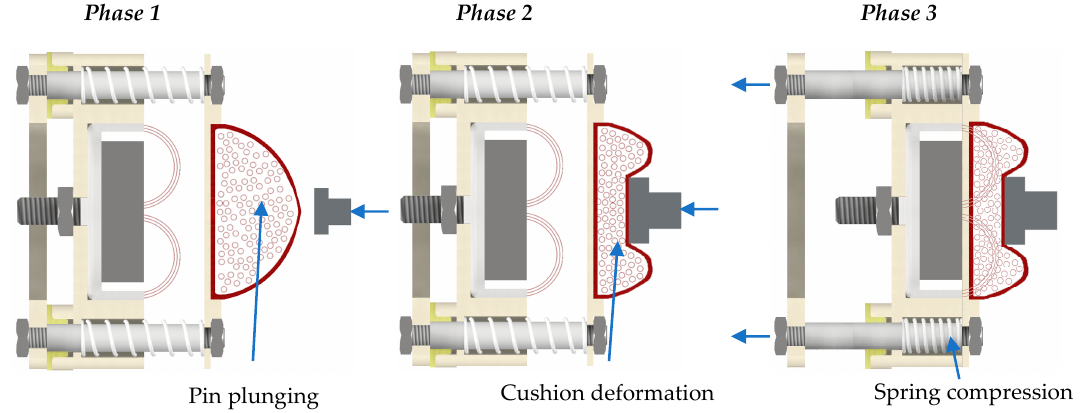
Figure 3. The principle of operation of the proposed magnetic spring solution in cross-sectional view of the jaw.